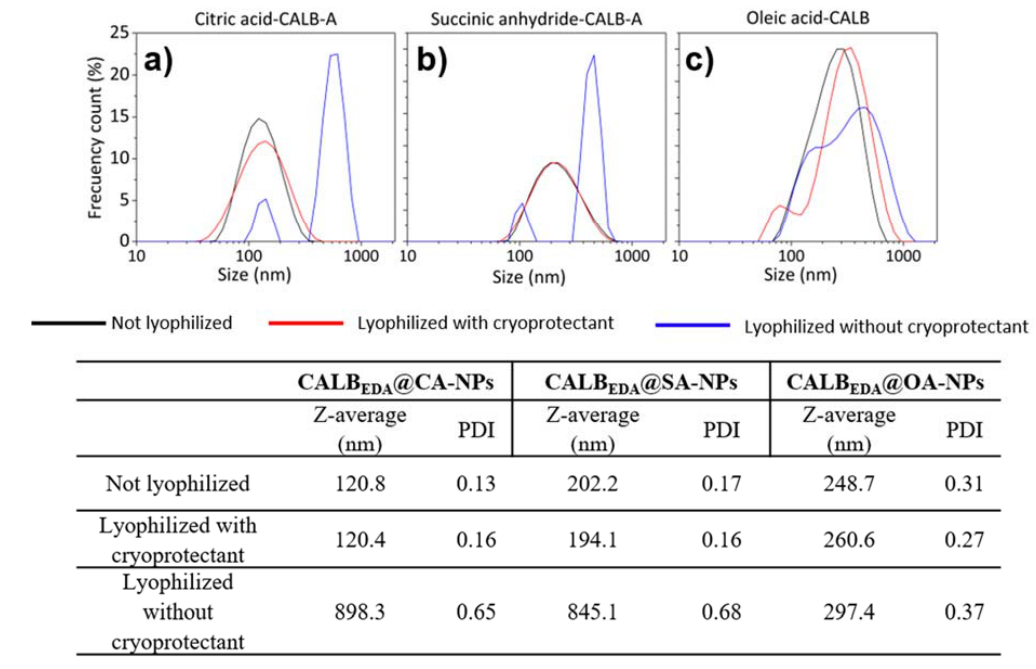
Figure 6. Colloidal properties CALB EDA -NPs in suspension and after lyophilization. Hydrodynamic sizes of CALB-immobilized NPs after storage in two different forms: aqueous suspension and freeze- dried. Lyophilized samples, with or without cryoprotectant (red and blue lines) and stored at 4 °C, were re-suspended in phosphate buffer 10 mM before the experiment. ( a ) Hydrodynamic size of